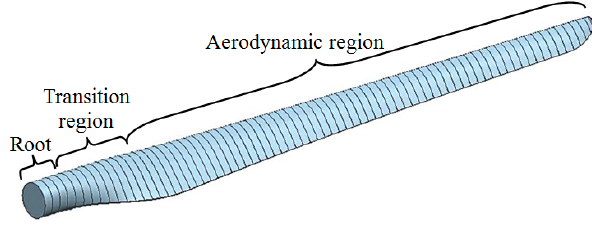
Figure 1. The geometry shape of the blade.